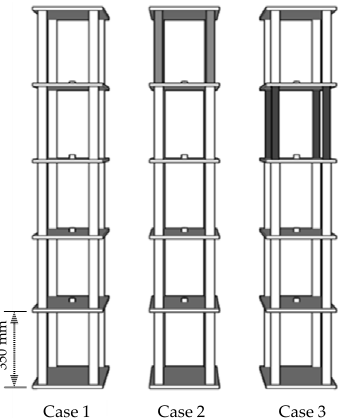
Figure 11. The sketch of the five ‐ story steel frame under different damage cases.